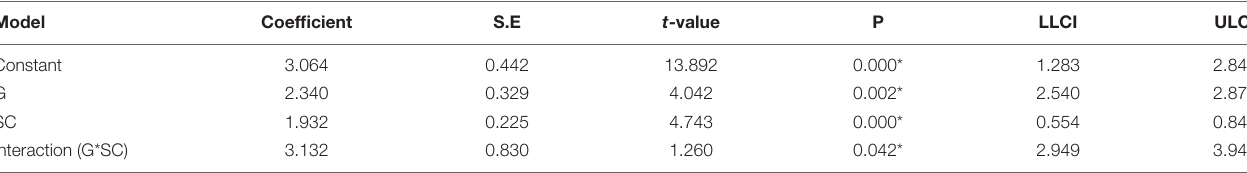
TABLE 6 | Results of moderation analysis.